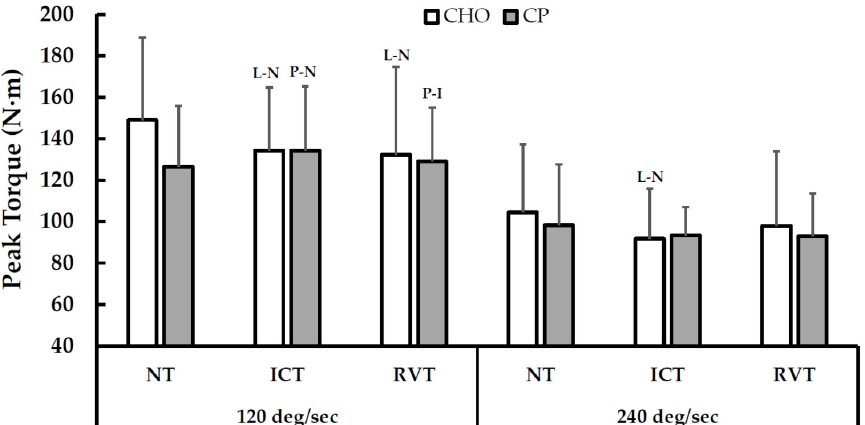
Figure 4. Effects of Training Periods and Nutritional Supplementation on Peak Knee Extensor Torque. Within-treatment effects: P-N = Possibly different than NT; L-N = Likely different